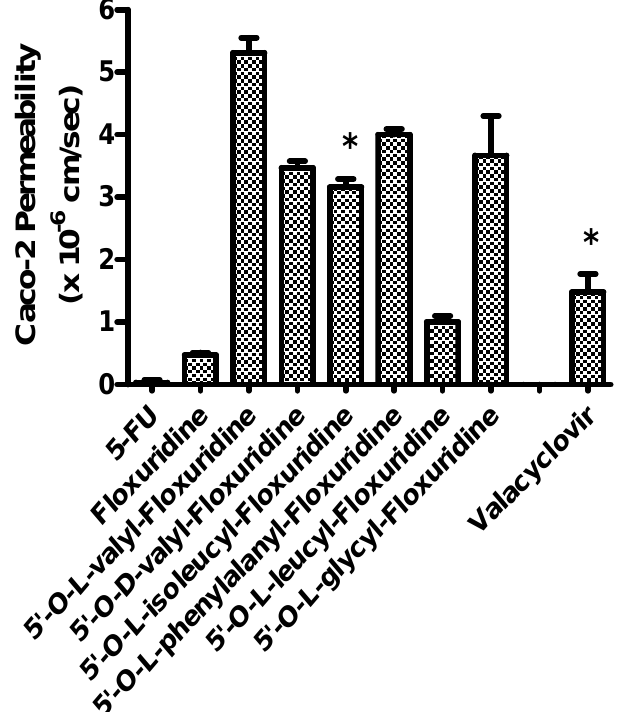
Figure 1. Caco-2 Permeability of 5-fluorouracil, floxuridine, and floxuridine prodrugs (Mean ±